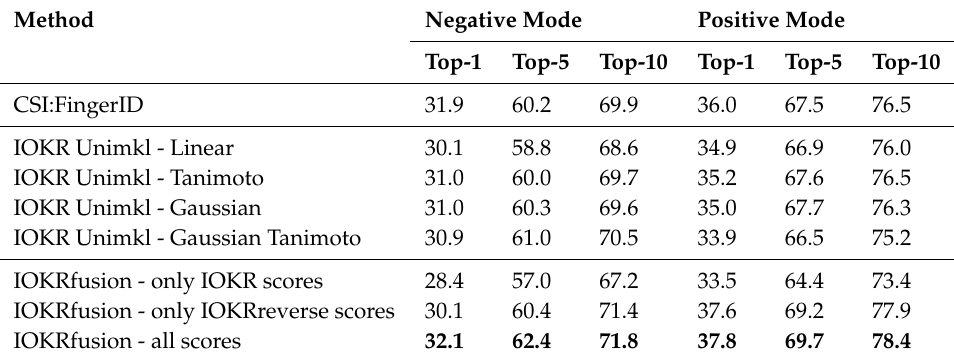
Table 2. Comparison of the top-k accuracy between CSI:FingerID, IOKR Unimkl and IOKRfusion in the negative and positive ionization modes. The highest top-k accuracies are shown in boldface.